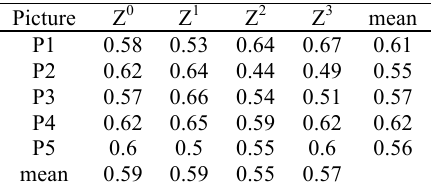
Table 4. Classification accuracies for SVM-RBF method, 10- best features selected using t-statistic.